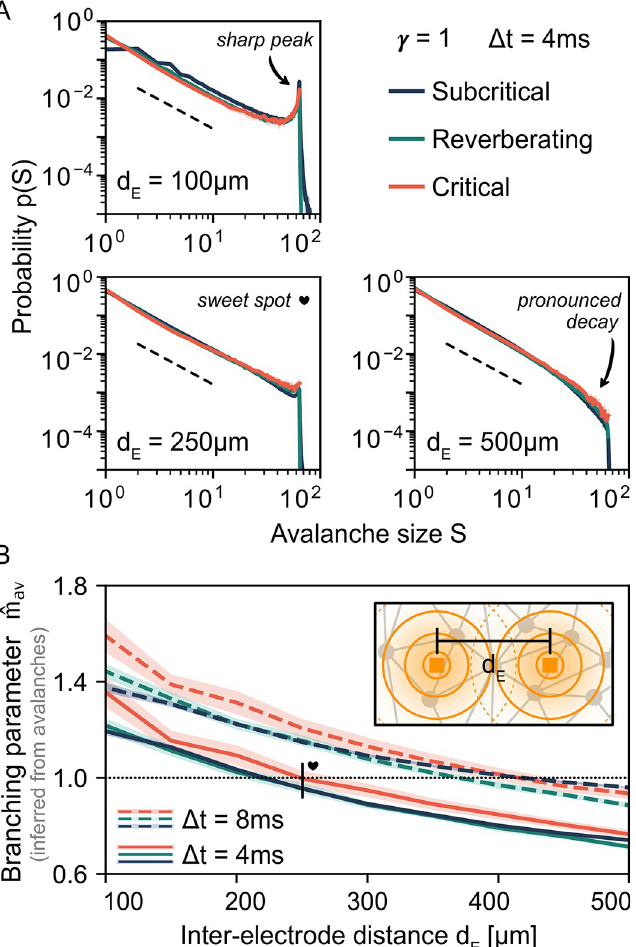
Fig 5. Under coarse-sampling, apparent dynamics depend on the inter-electrode distance d E . A : For small distances ( d E = 100 μ m), the avalanche-size distribution p ( S ) indicates (apparent) supercritical dynamics: p ( S ) � S − α with a sharp peak near the electrode number N E = 64. For large distances ( d E = 500 μ m), p ( S ) indicates subcritical dynamics: p ( S ) � S − α with a pronounced decay already for S < N E . There exists a sweet-spot value ( d E = 250 μ m) for which p ( S ) indicates critical dynamics: p ( S ) � S − α until the the cut-off is reached at S = N E . The particular sweet-spot value of d E depends on time-bin size (here, Δ t = 4 ms). As a guide to the eye, dashed lines indicate S − 1.5 . B : The inferred branching parameter ^ m is also biased by d E when estimated from neuronal avalanches. Apparent criticality ( ^ m av dotted line) is obtained with d E = 250 μ m and Δ t = 4 ms but also with d E = 400 μ m and Δ t = 8 ms. B, Inset : representation of the measurement overlap between neighboring electrodes; when electrodes are placed close to each other, spurious correlations are